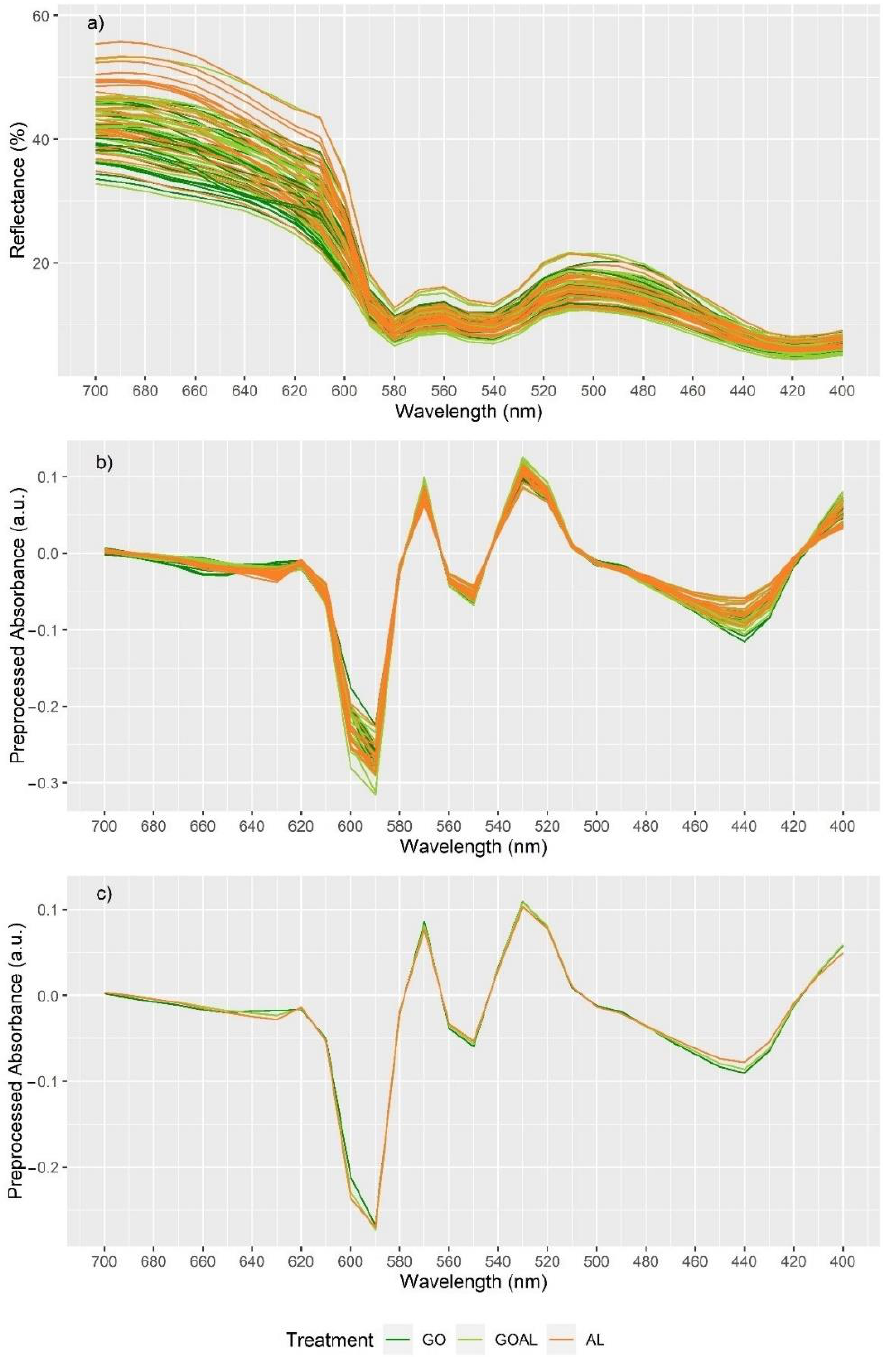
Figure 2. Visible reflectance spectroscopy of beef samples exposed to air for 24 h: ( a ) Individual reflectance spectra; ( b ) Individual absorbance spectra pre-processed using the Savitzky–Golay with 1st derivative algorithm; ( c ) average pre-processed spectra for GO, GOAL and AL samples.